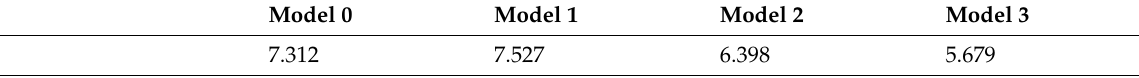
Table 3. Fixed and random part results for the multilevel regression models of male respondents, restricted to ages over 21, CHNS,